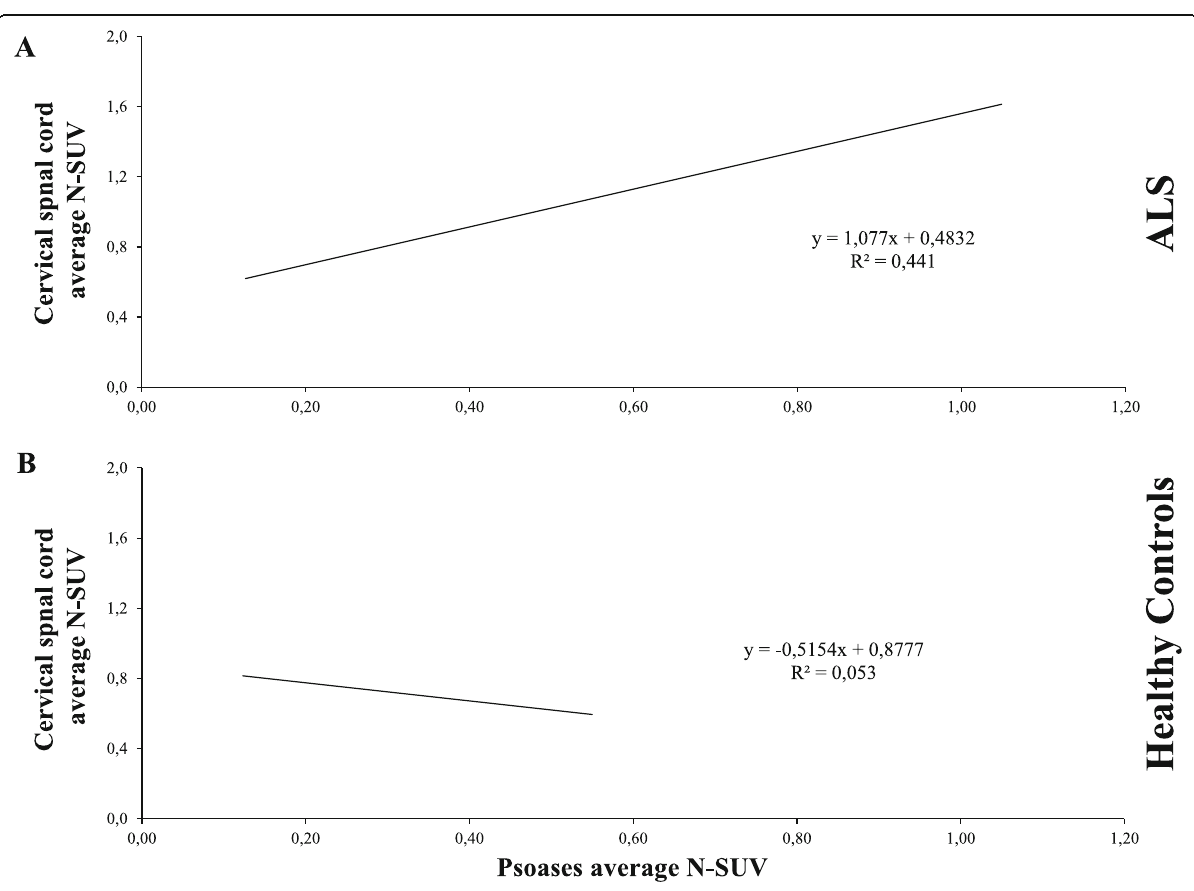
Fig. 2 Psoas FDG uptake mirrors spinal cord hypermetabolism in ALS. In ALS, a direct correlation between the cervical spinal cord and psoas average N-SUV was documented ( a ), while these two indexes were largely independent in healthy controls ( b